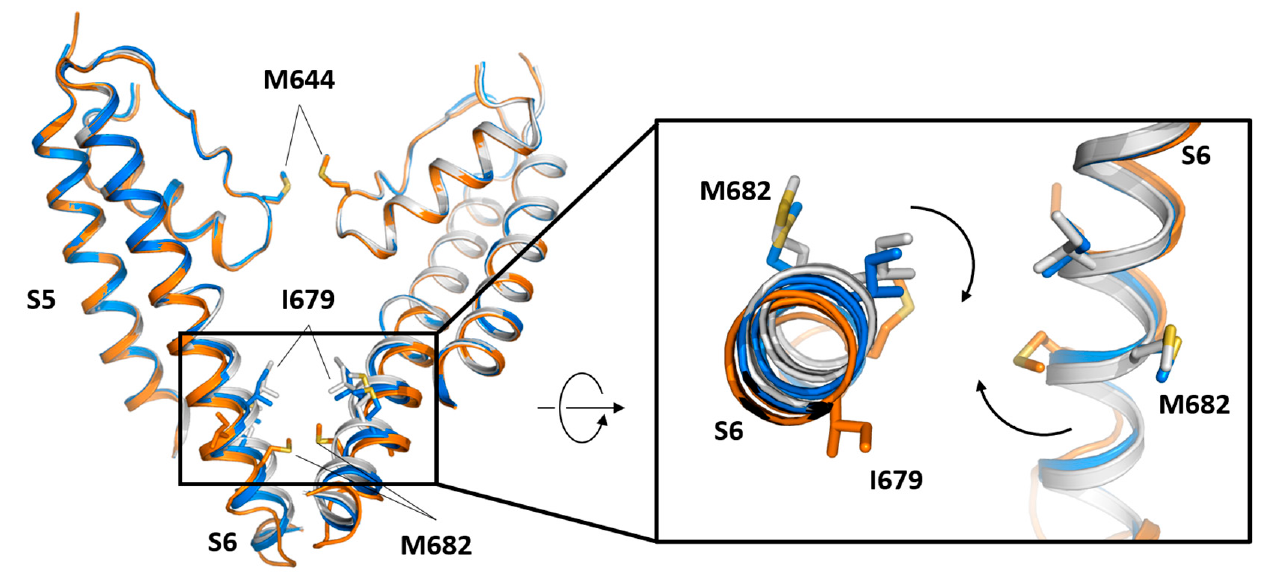
Figure 5. TRPV1 channel gating. The image illustrates differences between TRPV1 states captured by cryo-EM. The open state (blue marine) and the closed states C1 (grey) and C2 (orange) have been superimposed using the entire tetrameric channel (left). The structures correspond to mammal TRPV1 (PDB code: 7L2L (open), 7L2N (C1), and 7MZ5 (C2) [14]). Only two subunits are represented for simplicity. The three structures have the RTX bound, and the backward movements of the transmembrane S6 helix reveal conformational transition upon RTX binding. Progressive movements are centered in the lower part of S6 (zoomed view; right), while the selectivity filter remains static. Residues M682 and I679 are rotated into the pore. Arrows indicate S6 movement and side chain rota ‐ tions.